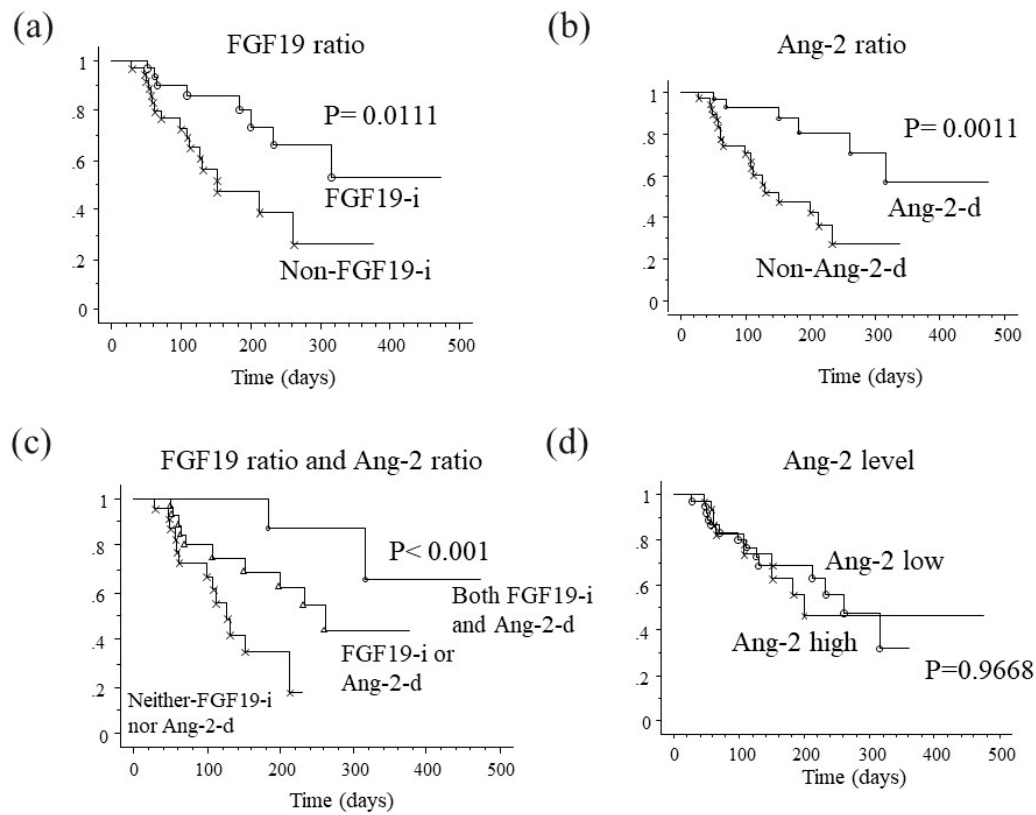
Figure 4. Association between changes in FGF19 and Ang-2 levels and progression-free survival. Kaplan-Meier analysis of 74 hepatocellular carcinoma (HCC) patients who received Lenvatinib treatment, stratified according to ratio of fibroblast growth factor (FGF) 19 (grouped based on a cut-off ratio of 1.51 at 4 weeks versus baseline) ( a ), ratio of angiopoietin-2 (Ang-2) (grouped by a cut-off ratio of 0.67 at 4 weeks versus baseline) ( b ), ratio of FGF19 and Ang-2 ( c ), and level of Ang-2 ( d ). FGF19-i represents a FGF19 ratio at 4 weeks/baseline of >1.51 and Ang-2-d represents an Ang-2 ratio at 4 weeks/baseline of <0.67. Ang-2 high represents an Ang-2 baseline levels >7432 pg/mL, Ang-2 low represents an Ang-2 baseline levels < 7432 pg/mL.